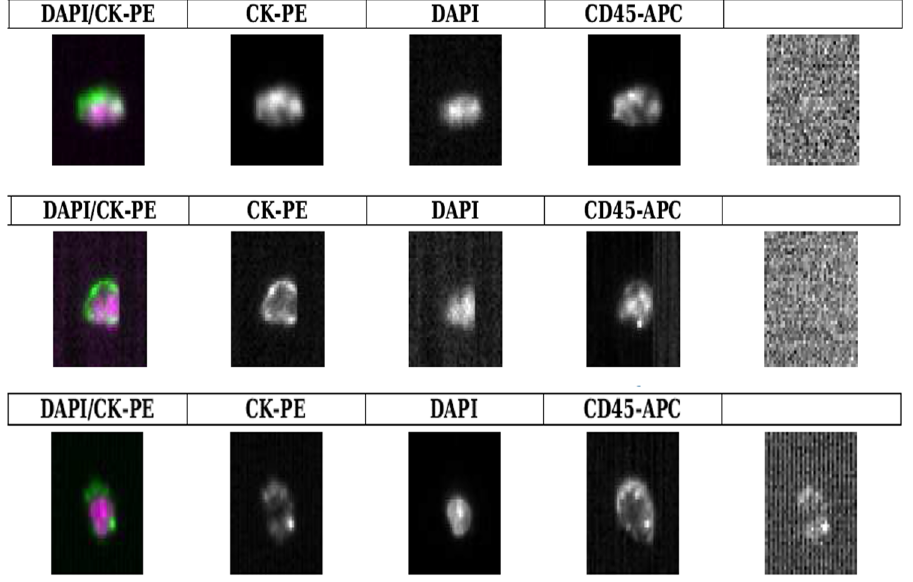
Figure 5. CTCs isolated from 3 different patients with locally advanced ovarian cancer with peritoneal carcinomatosis but no distant metastases (M 0 ). These photos are representative of dual stained CTCs detected using the CellSearch ® system: dual CK (+) CD45 (+) nucleated cells after EpCAM-based enrichment step.